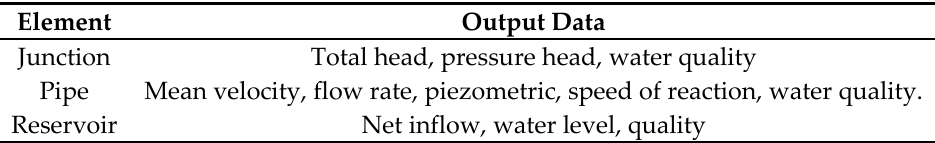
Table 2. Output results for some network’s